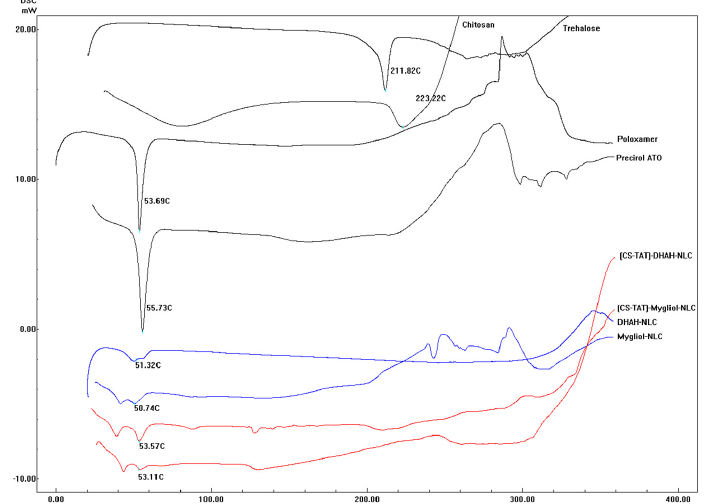
Figure A1. Differential scanning calorimetry (DSC) graphs of pure excipients (D-trehalose, Poloxamer 188, Precirol ATO 5, chitosan (CS) and the different developed nanoparticles).